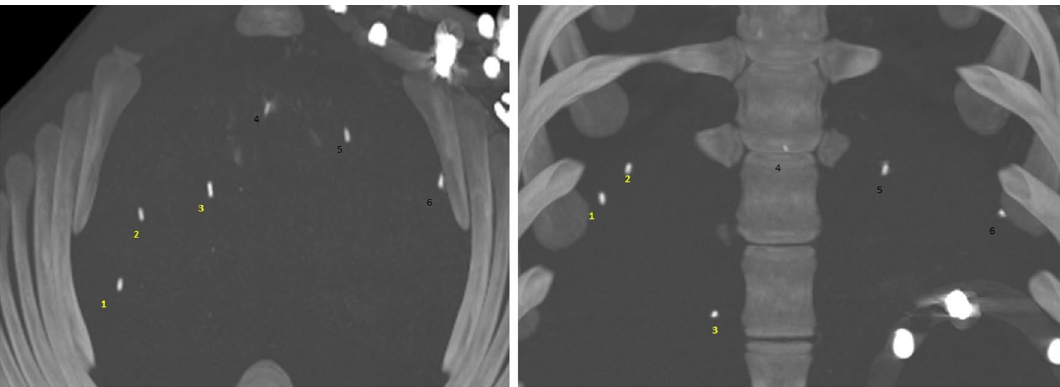
Figure 6. Axial and coronal maximum intensity projection CT images showing the placement of fiducials in a swine